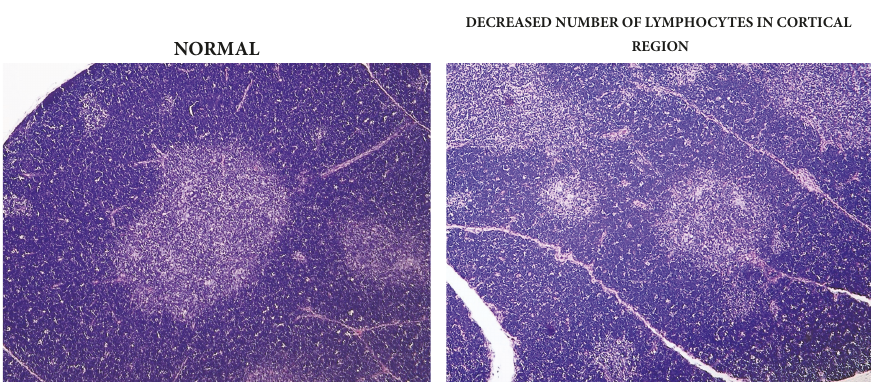
Figure 2: Thymus gland: comparison of normal (control) tissue to tissue in a male from the 3000/4000 mg/kg bw/day group showing decreased number of cortical lymphocytes, 14-day